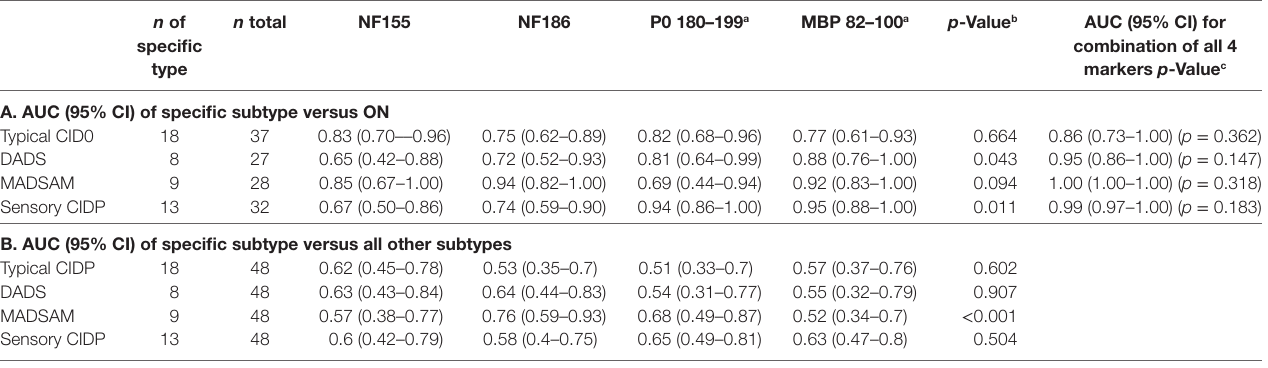
TaBle 1 | ROC analysis of antigen-specific T cell responses as markers for CIDP and its subtypes.